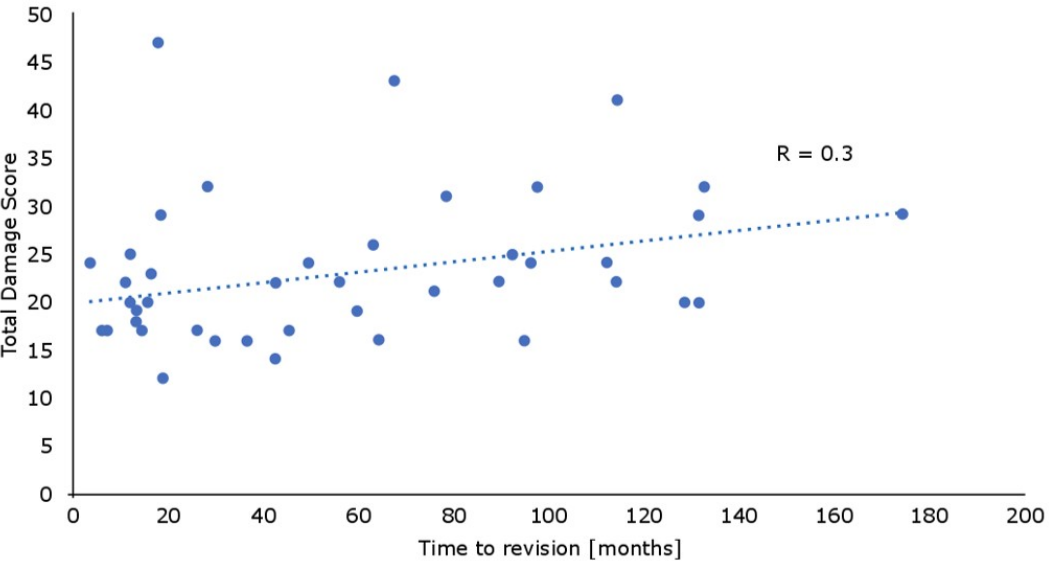
Figure 5. With the increasing time to revision, the total damage score increased (p < 0.05), but this correlation was weak (R = 0.3).